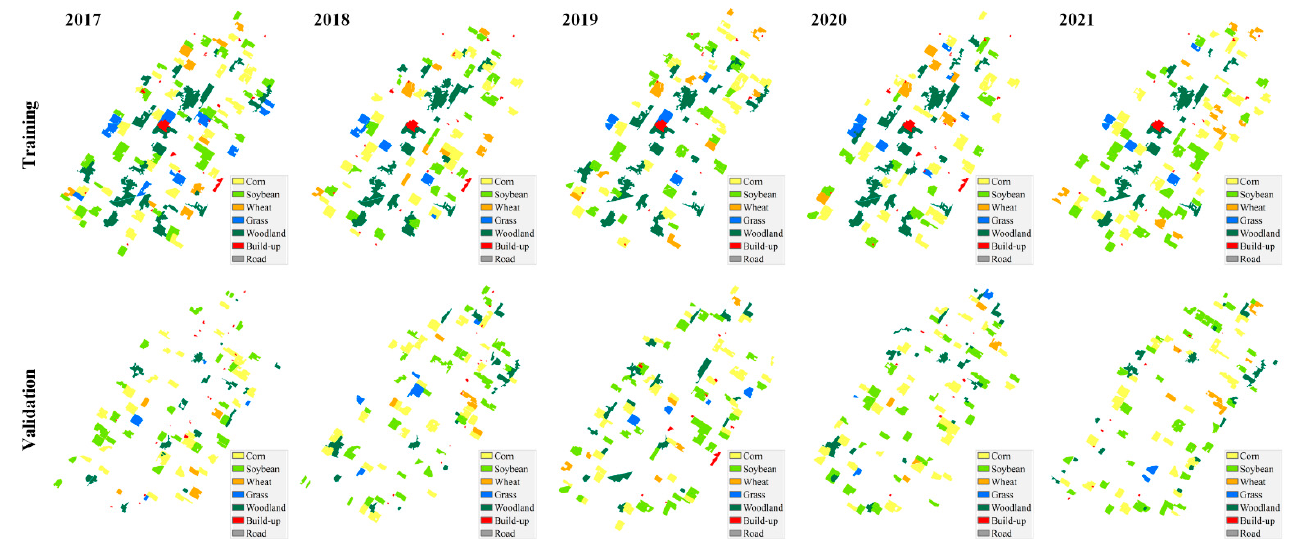
Figure 2. Ground truth data for crop classification and validation from 2017 to 2021.